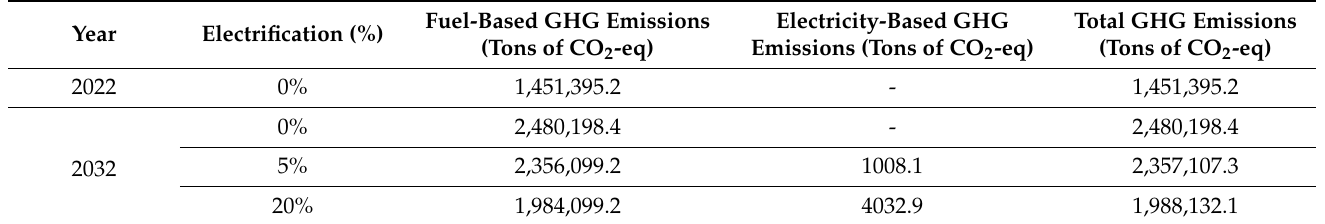
Table 3. Total amounts of GHG emissions produced by conventional and electric freight transporta- tion